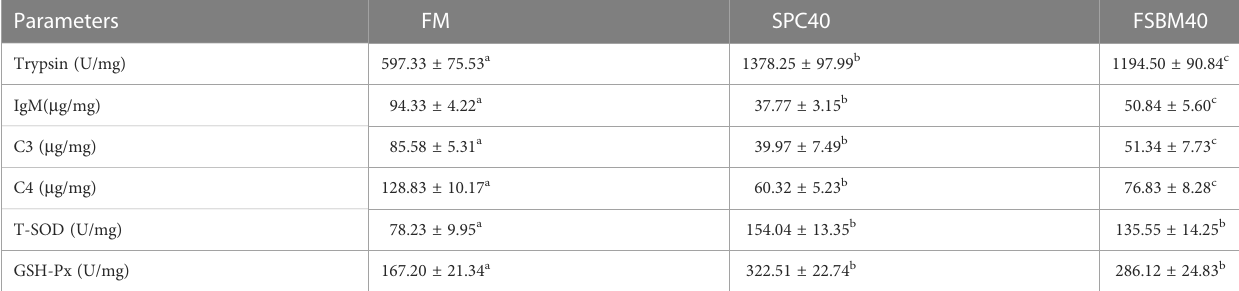
Data in the same row with different superscripts indicate signi fi cant differences (P <